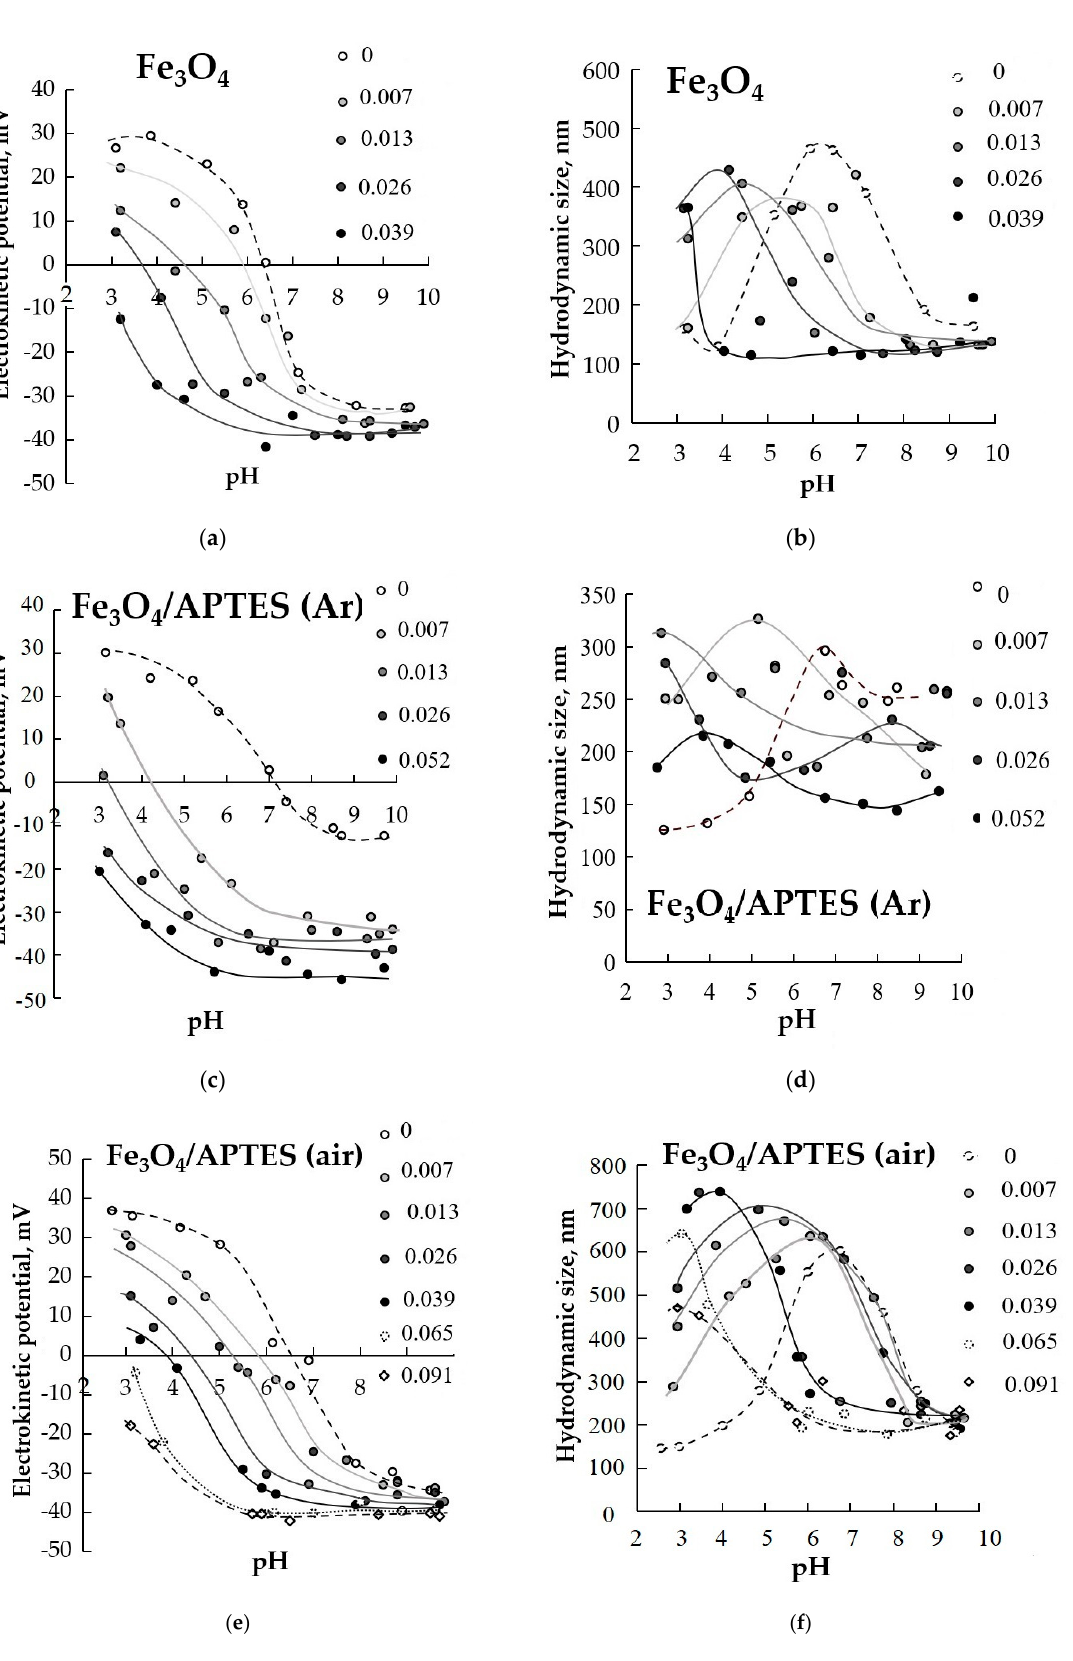
Figure 7. Effect of humic acids (g/g) adsorption on pH-dependent surface charging ( a , c , e ) and average hydrodynamic size of NPs ( b , d , f ) (zeta potential is proportional with the particle charge, 0.01 M KCl) ( p -value <